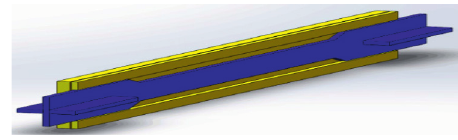
Figure 4: 3D diagram of BRB.